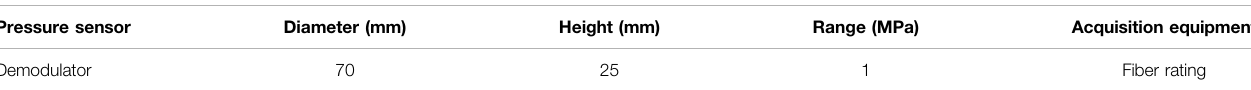
TABLE 4 | Pile top pressure sensor parameters.